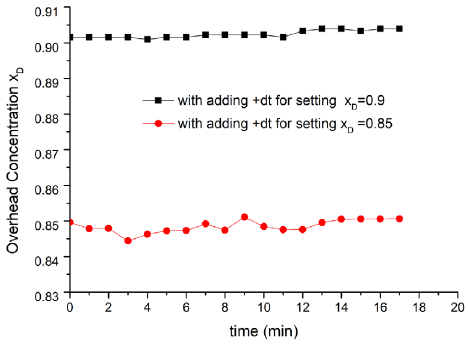
Fig. 7. Overhead concentration for setpoints at 0.85, and 0.9 with dynamic-time (+ dt ).